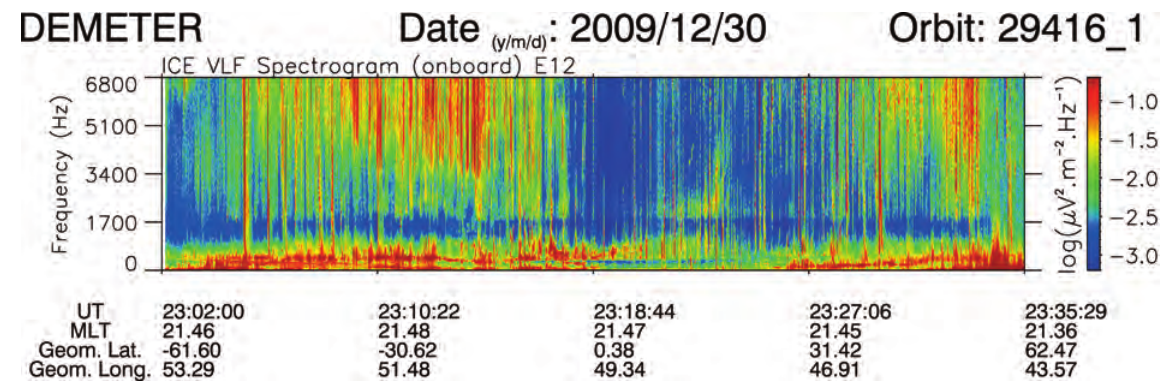
Figure 6. Frequency-time spectrogram of the power spectral density of the electric field fluctuations recorded by DEMETER along a complete half-orbit on December 30, 2009. Note the clear cut-off frequency of the whistlers (vertical lines) at about 1,700 Hz. The cut-off frequency remains relatively constant over all of the sampled